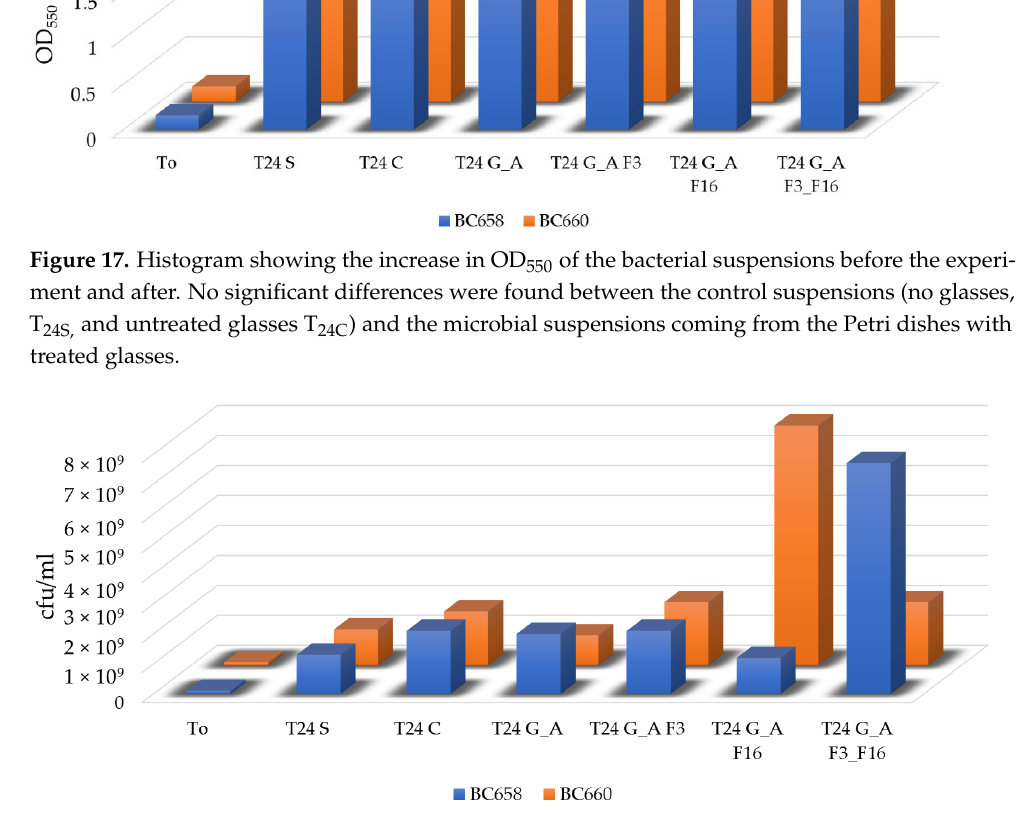
Figure 18. Histogram showing the increase in number of vital bacteria (cfu/mL) after 24 h of incubation in the inoculated liquid medium in presence of untreated and treated glasses. Results were coherent to the OD measurement, except for BC658 in presence of F3/F16 glass slides and for BC660 in the medium in presence of glass slides treated with F16, where a higher number of bacteria was recovered.